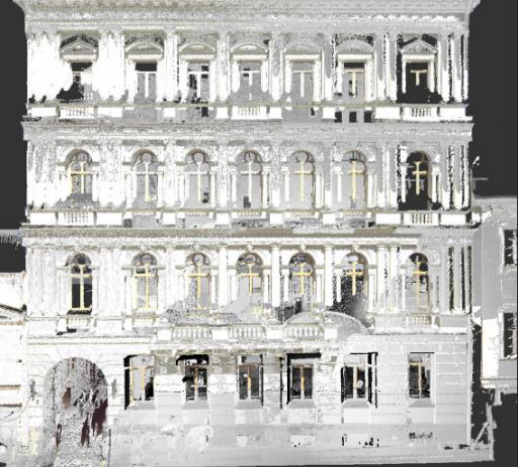
Figure 4. Historical heritage case study